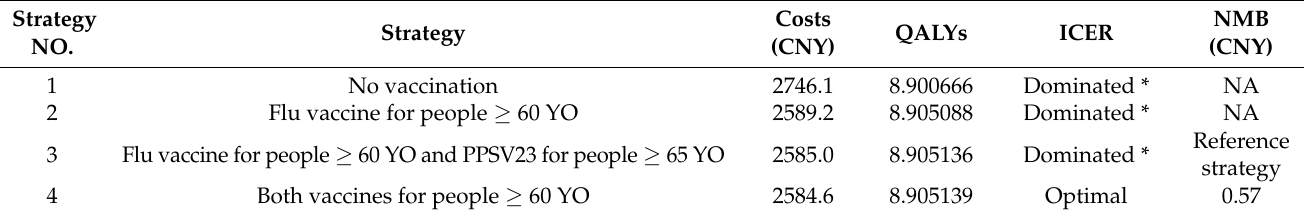
Table 2. Base-case